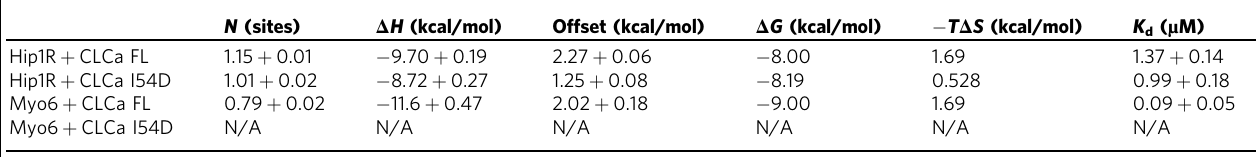
Table 2 Thermodynamic parameters obtained by isothermal titration calorimetry N